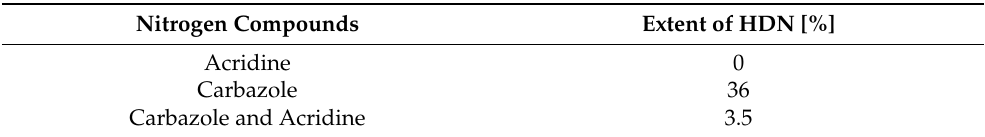
Table 2. The extent of HDN at a reactor temperature of 300 ◦ C with different organic nitrogen compounds present at a concentration of 2.4 mmol/dm 3